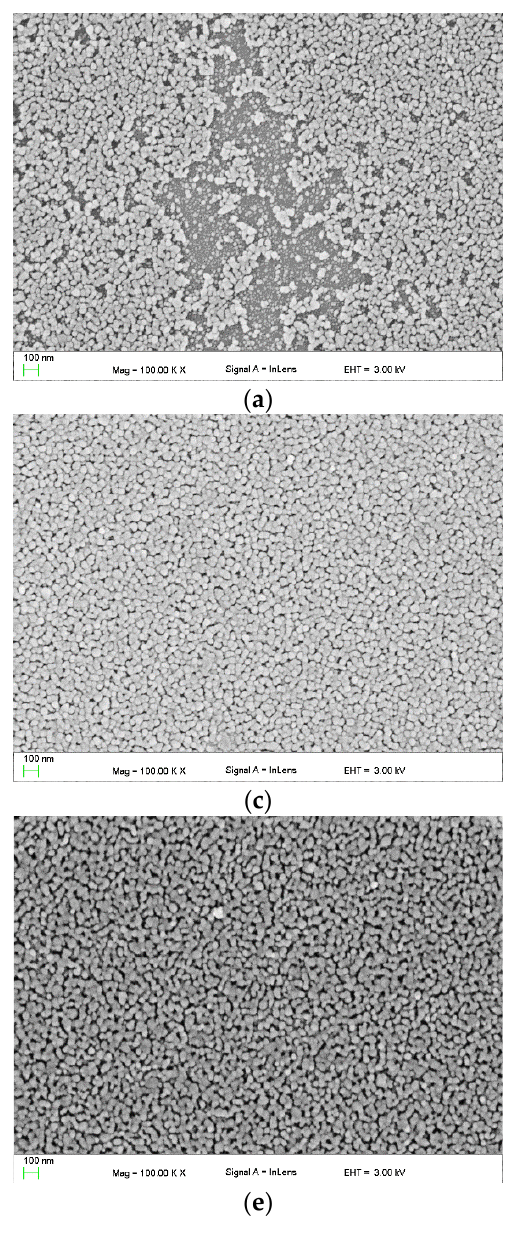
Figure 8. Top view SEM images of the ZnO films, respectively: ZnO ‐ 2 ( a ), ZnO ‐ 14 ( b ), ZnO ‐ 30 ( c ), ZnO ‐ 41 ( d ), and ZnO ‐ 64 ( e ).